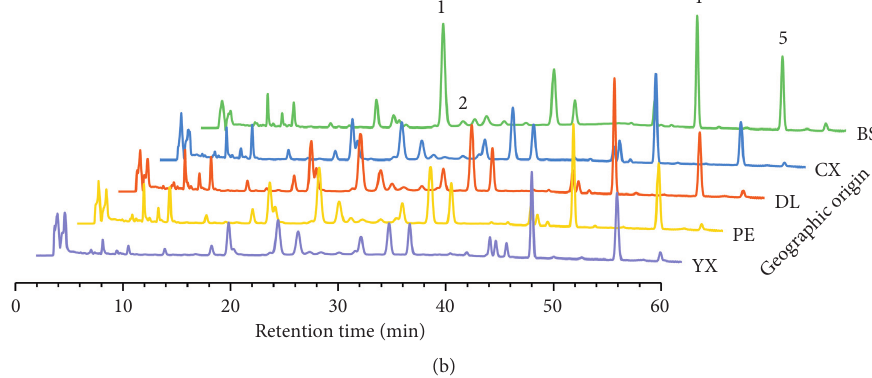
Figure 4: The chromatograms of wild (a) and cultivated (b) M. cocos samples from five geographical origins. Peaks 1–5 are dehy- drotumulosic acid, poricoic acid A, 3-epidehydrotumulosic acid, dehydropachymic acid, and dehydrotrametenolic